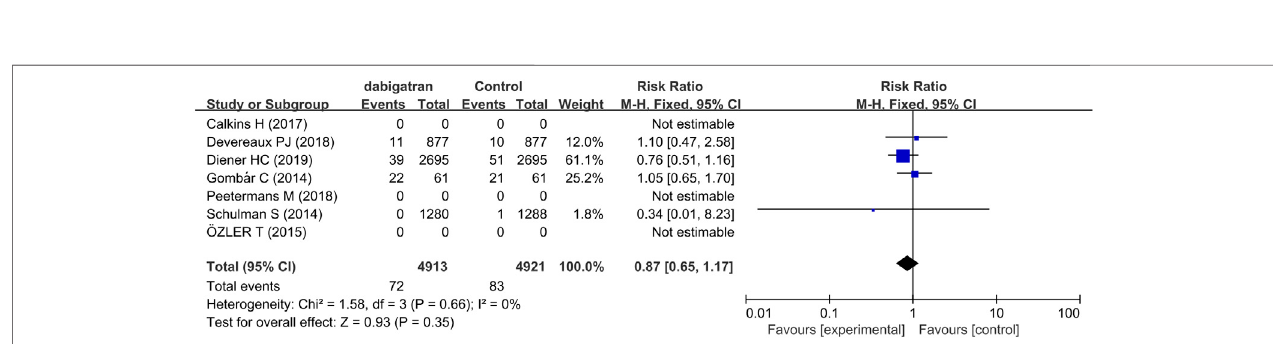
FIGURE 7 | Forest plot comparing the RR of fatal bleeding events between the experimental (dabigatran) and control groups.